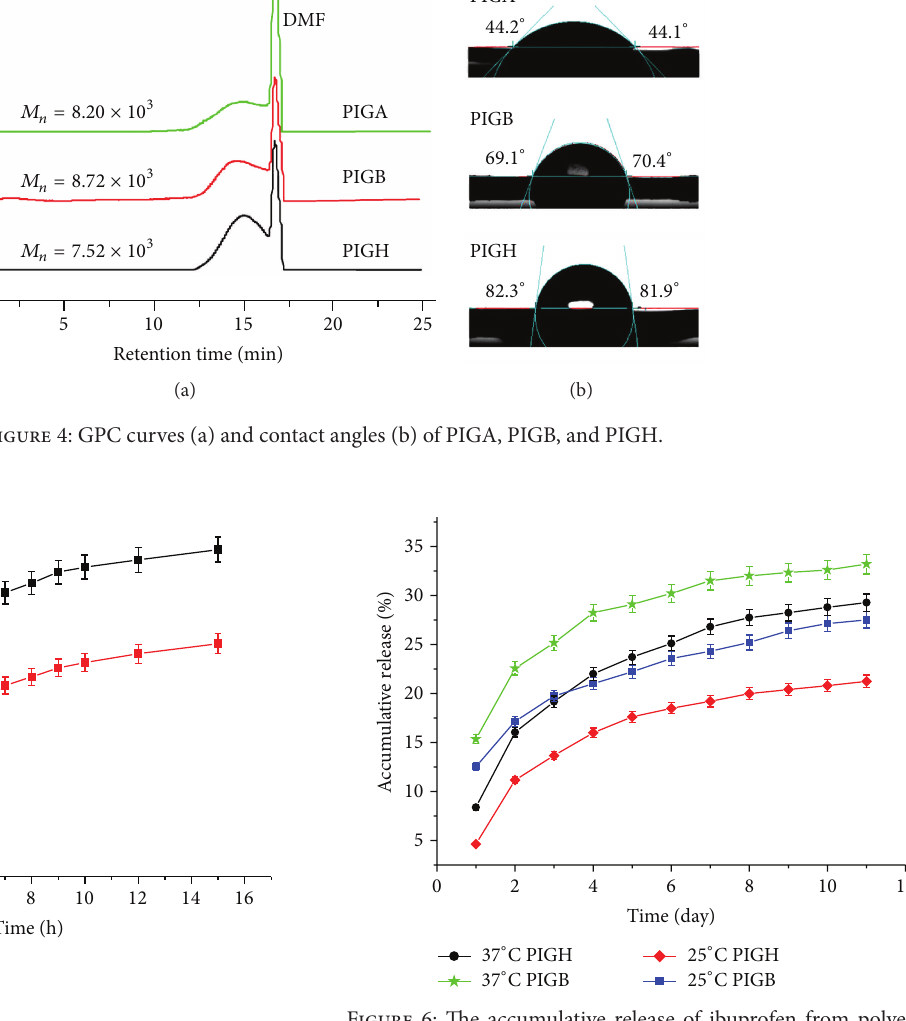
Figure 5: The accumulative release of ibuprofen from polyester- amide (PIGA).